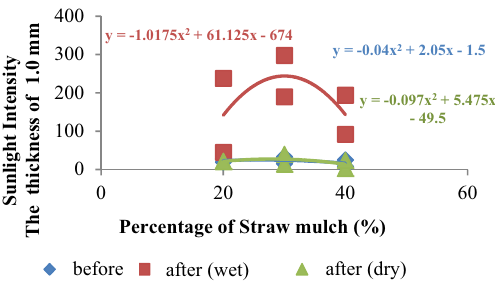
Fig. 9 The correlation between sunlight intensity and the percentage of water hyacinth in 1.0 mm organic mulch sheet Table 4 The result of correlation analysis between chemical charac- teristics of mulch materials and tensile strength of mulch Chemical characteristics of mulch